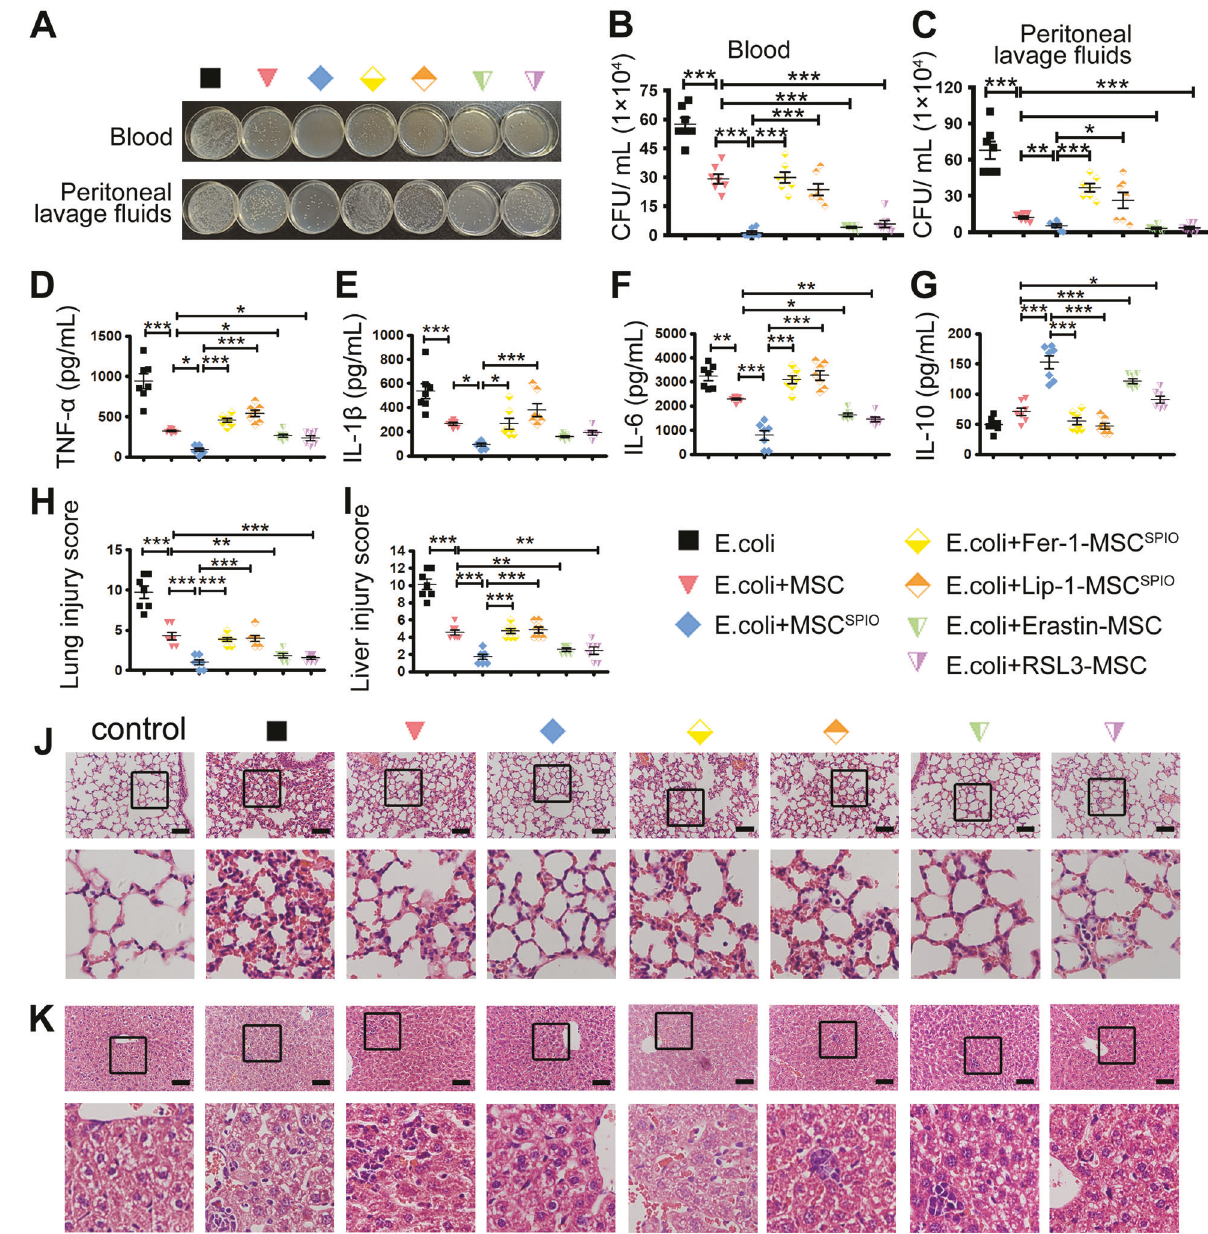
Fig. 6 MSC SPIO protect mice against sepsis via ferroptosis. Mice were injected with 2 × 10 7 CFU E . coli intraperitoneally and then injected with 1 × 10 6 MSCs, MSC SPIO , MSC SPIO pretreated with Fer-1 (10 μ mol/L) or Lip-1 (20 μ mol/L), MSCs pretreated with Erastin (100 nmol/L) or RSL3 (10 nmol/L) intravenously. Blood and peritoneal lavage fl uid from mice 4 h after infection was plated for 16 h. A The representative plate shows bacterial colonies. B , C Colony counting of samples from B blood and C peritoneal lavage fl uid. D – G Cytokines levels in sera were determined by ELISA. H – K Mice were treated as described before and sacri fi ced at 48 h after infection. Representative H&E staining of J lung sections or K liver sections, and histological injury of the H lungs and I livers were scored as described in Materials and Methods. Data are shown as mean ± SEM ( n = 7). * p < 0.05; ** p < 0.01; *** p <